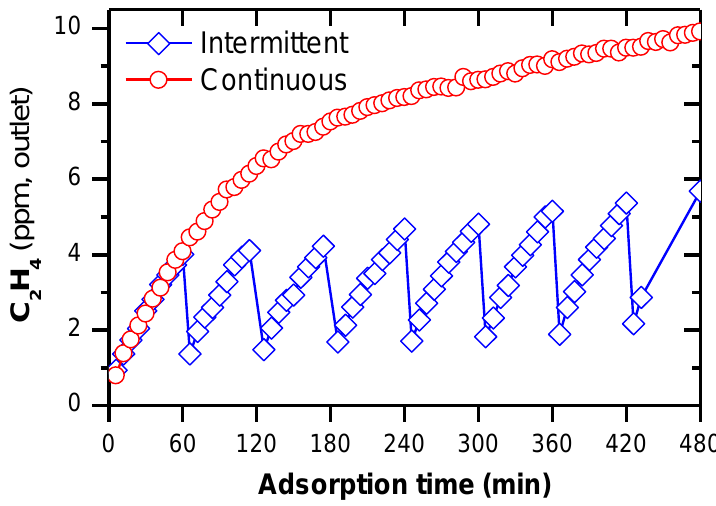
Figure 6. A comparison between continuous adsorption and intermittent adsorption (adsorption and plasma-catalytic oxidation).